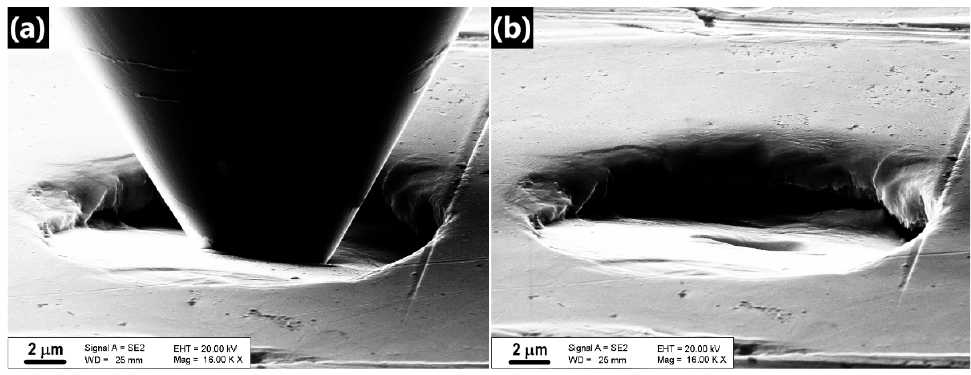
Figure 11. SEM micrographs of a T91 FIB membrane after micro-punch test showing: ( a ) spherical punch embedded in the membrane; ( b ) membrane after retracting the punch.